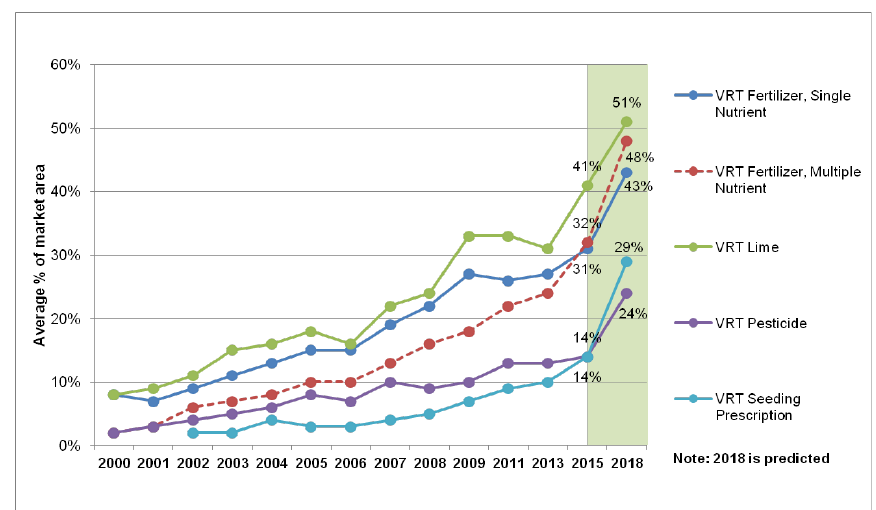
Fig. 4. Estimated market area using VRT technology over time (adapted from Erickson and Widmar, 2015). Figure 2 above can be used to identify key